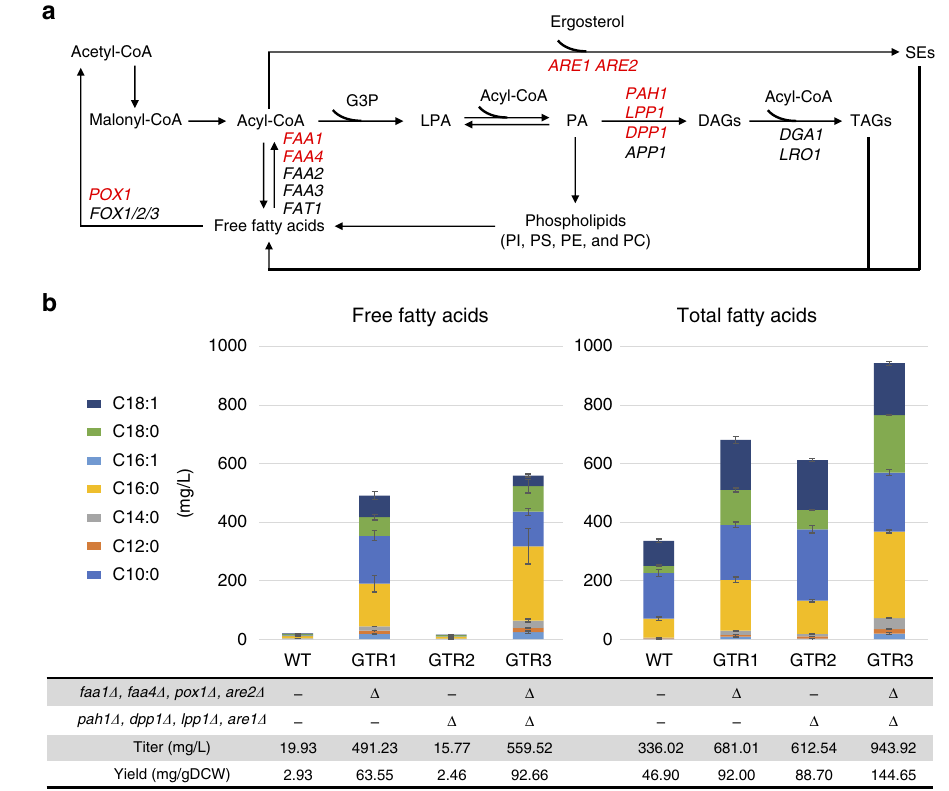
Fig. 6 Application of the Lightning GTR-CRISPR for free fatty acids production. a Schematic representations of lipid metabolism in S. cerevisiae . Gene names in red represent deletion targets by the Lightning GTR-CRISPR system. G3P glyceraldehyde 3-phosphate, LPA lysophosphatidic acid, PA phosphatidic acid, DAG diacylglycerol, TAG triacylglycerol, SE sterol ester, PI phosphatidylinositol, PC phosphatidylcholine, PE phosphatidylethanolamine, PS phosphatidylserine. FAA1 and FAA4 encode fatty acyl-CoA synthetases; POX1 encodes a fatty acyl-CoA oxidase; PAH1 , DPP1 , and LPP1 encode phosphate phosphatases, which dephosphorylate PA to yield diacylglycerol; and ARE1 and ARE2 encode acyl-CoA:sterol acyltransferases. b Free fatty acid and total fatty acid production in yeast deletion strains. Free fatty acids (intracellular and extracellular) and total fatty acids (including fatty acid chains in lipids: TAGs, SEs, phospholipids, etc.) were quanti fi ed when the strains were grown for 72 h in minimal medium containing 2% glucose. The data points of bar charts represent mean averages of indicated fatty acids. The error bars indicate the standard deviations of three biological replicates. Source data are provided as a Source Data fi